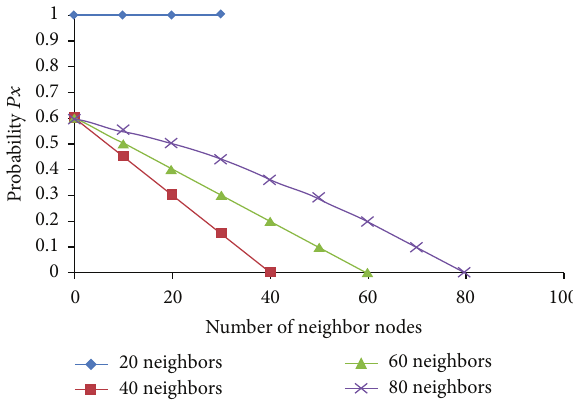
Figure 1: FP at node 𝑁 versus number of covered